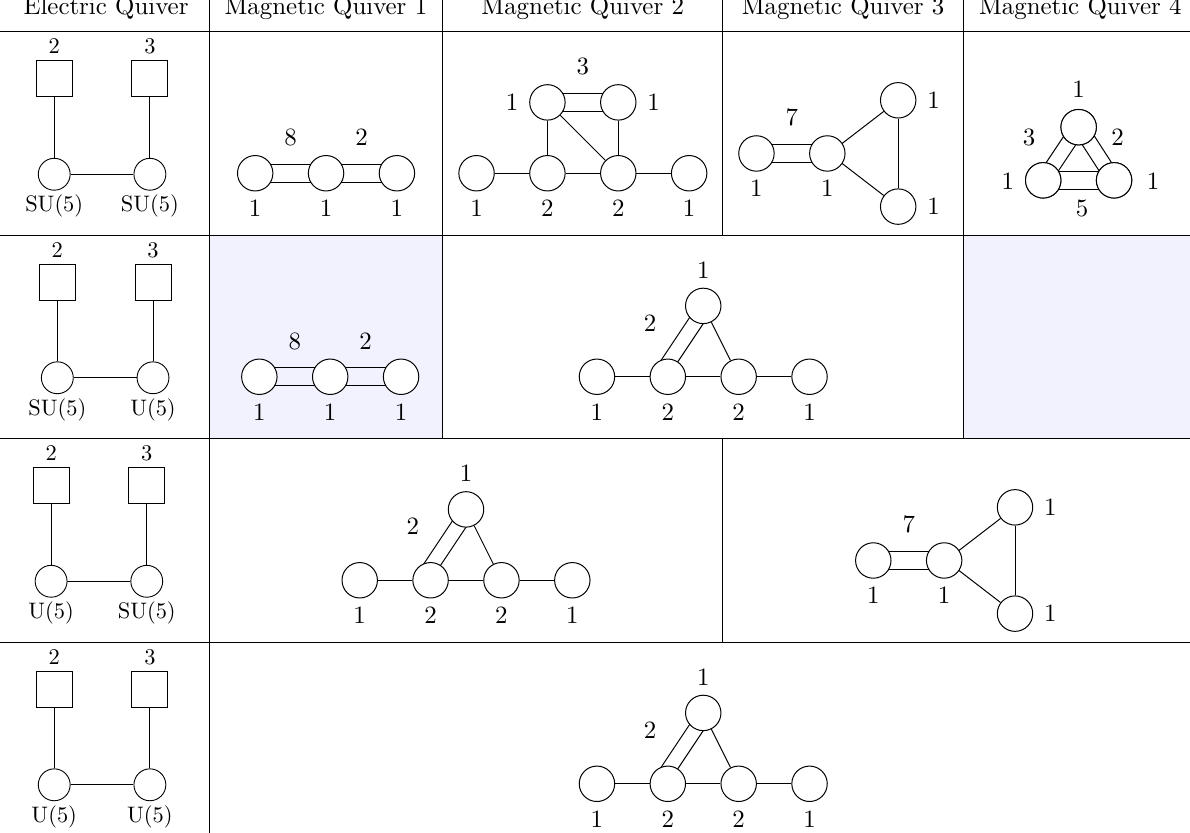
Table 7 . The first row displays the electric theory and the four corresponding magnetic quivers. The next few rows show how the magnetic quivers change as the SU nodes in the electric theory are turned into U nodes. We observe how distinct subdivisions of the brane web (and hence their magnetic quivers) become identical when some of the SU nodes are turned to U nodes. The light blue colored box indicates the same magnetic